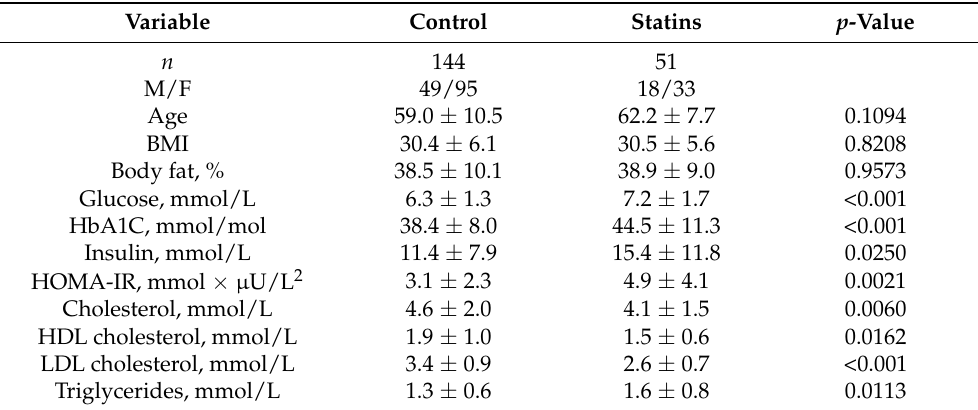
Table 3. Anthropometric and fasting biochemical characteristics of healthy subjects (Control) and statin patients (Statins) involved in the study.